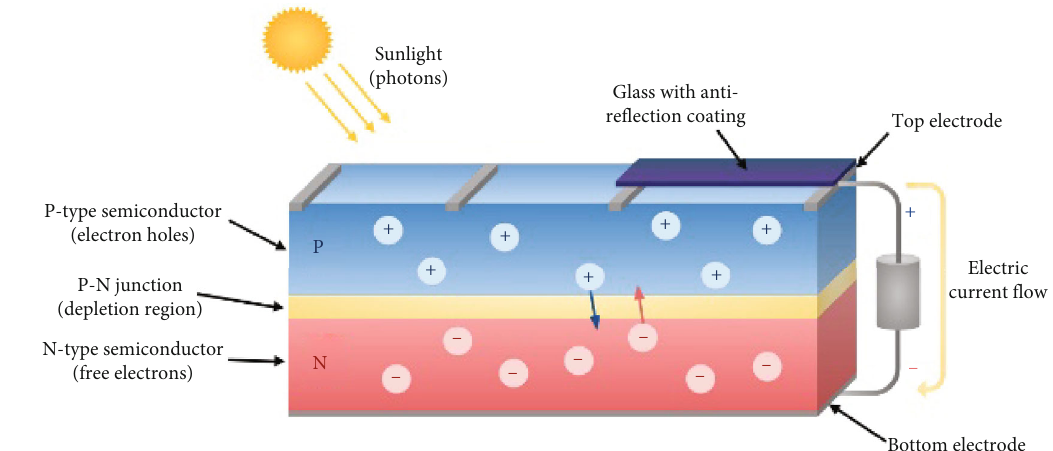
Figure 1: Solar cell.